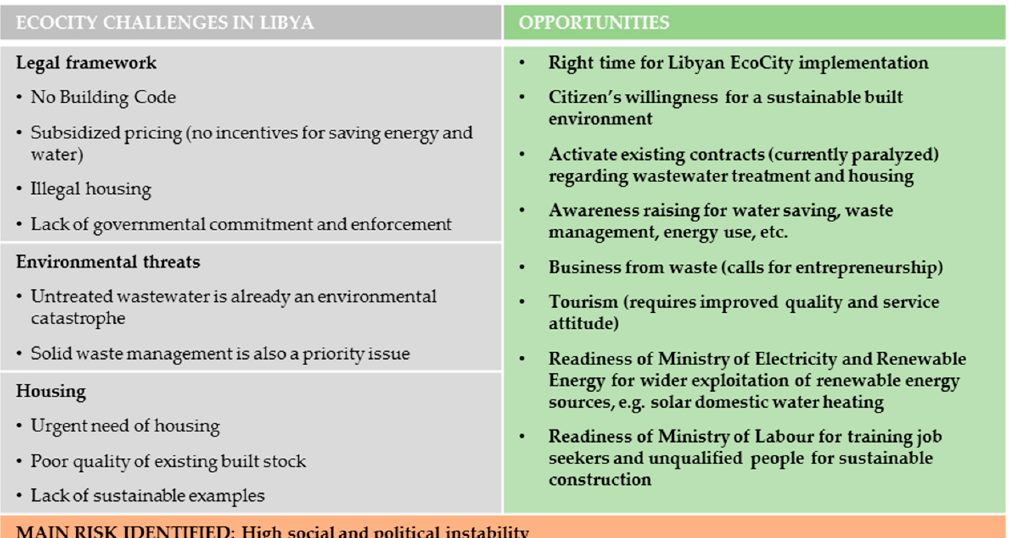
Figure 4. Challenges and opportunities for EcoCity development in Libya. (Carmen Antuña-Rozado, 2018).